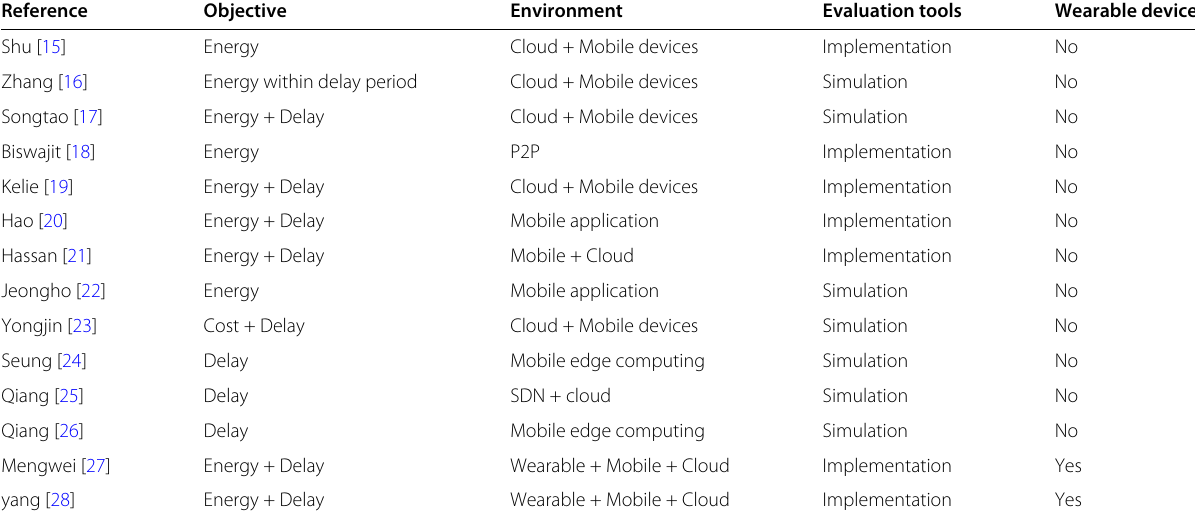
Table 1 Literature study on offloading mechanisms